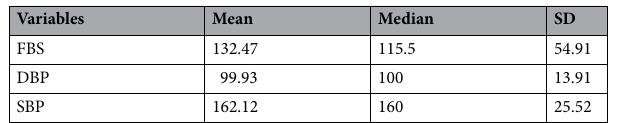
Table 2. Baseline characteristics of continuous variables of the patients. NB FBS Fasting blood sugar, DBP Diastolic blood pressure, SBP Systolic blood